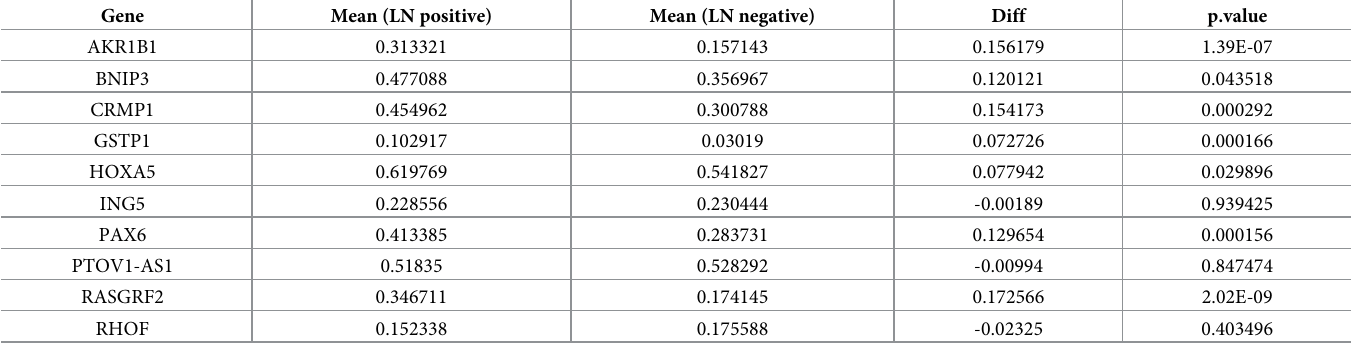
Table 4. List of 10 amplicon in the promoter region between ER-positive and HER2-negative breast cancers with and without axillary lymph node metastasis by using targeted bisulfite sequencing.